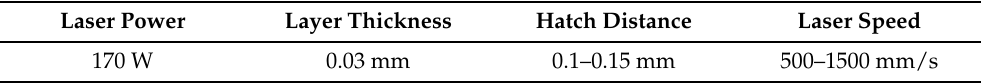
Table 3. Processing parameters used for printability study of Al-Mg-Sc-Zr